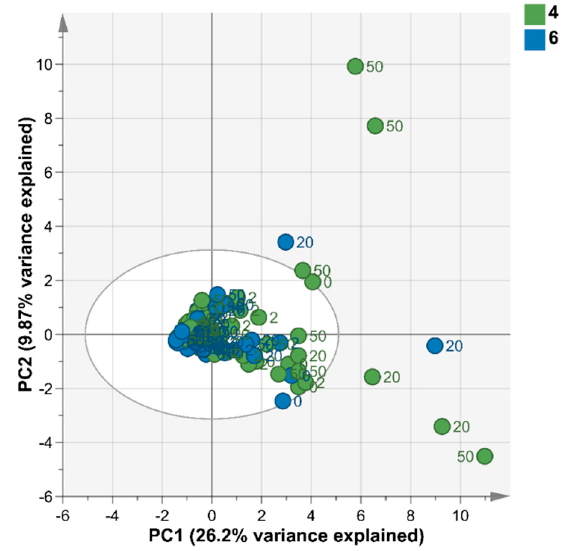
Figure 6. Metabolic profiling of the Desmodesmus sp. AARLG074 cultivated under di ff erent copper and pH conditions. The score scatter plot from PCA plot of GC-MS results of Desmodesmus sp. AARLG074 that were cultured in JM under various copper concentration (0, 2, 20 and 50 mg / L) at pH 4 and pH 6. Each dot represents one biological replicate. The colour of dot represents the cultivation pH condition-pH 4 (green) and pH 6 (blue) and the labelled number beside dots represent the copper concentration as mg / L in the JM.